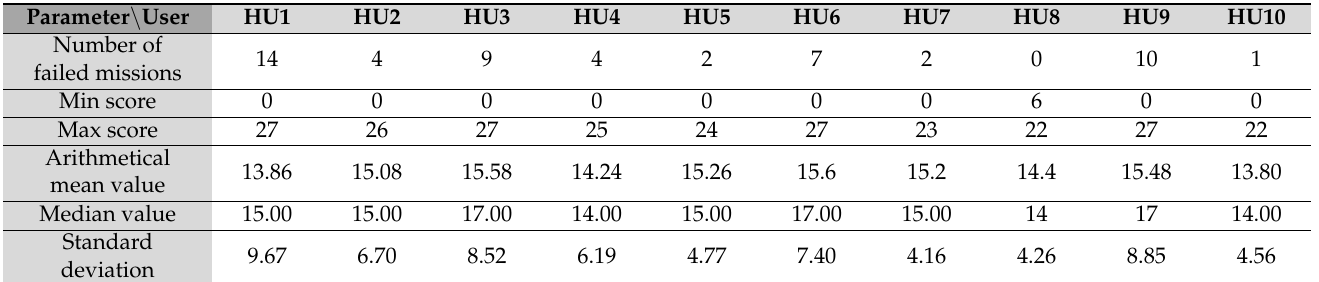
Table 2. Performance data of untrained human users in a static mode environment, based on the 50 simulation